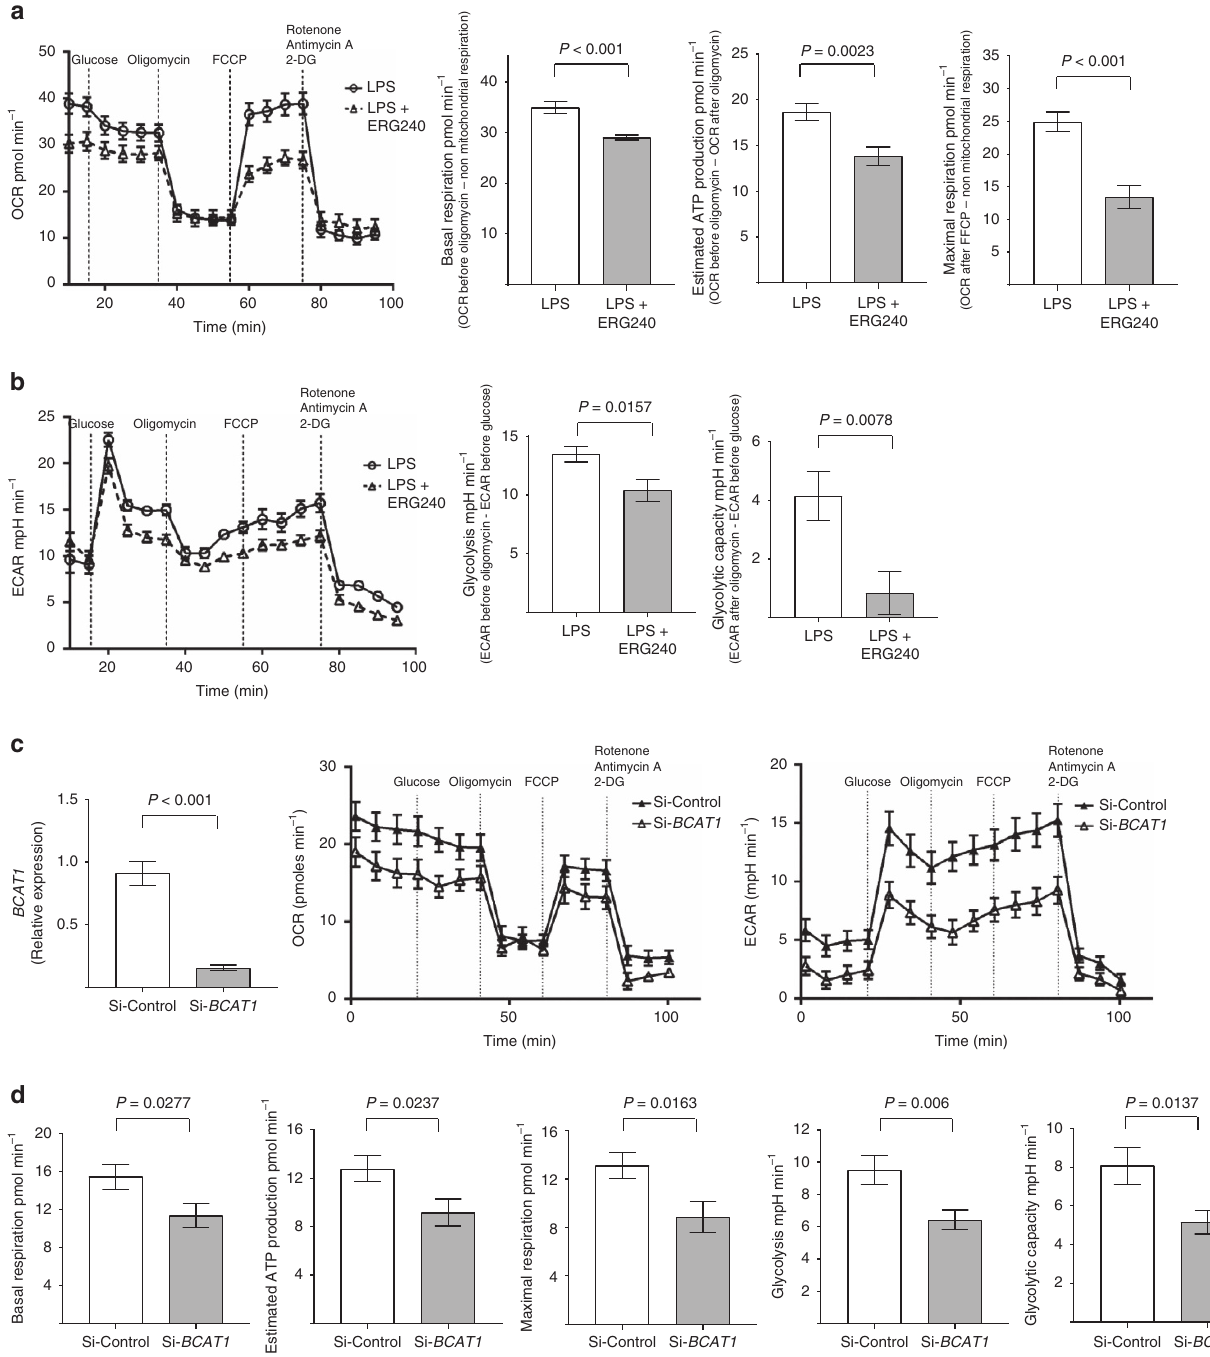
Figure 2 | BCAT1 inhibition reduces oxygen consumption and glycolysis in human macrophages. ( a ) Real-time extracellular OCR measurements in hMDMs (left panel) that were previously treated with either LPS (100ngml (cid:2) 1 ) or LPS þ ERG240 (20mM) for 3h. OCR values were recorded following sequential treatments with glucose (5mM), oligomycin A (0.5 m M), carbonyl cyanide 4-(trifluoromethoxy) phenyl- hydrazine (FCCP, 1 m M) and a combination of 2-deoxy-D-glucose (2-DG, 50mM), antimycin A (1 m M) and rotenone (1 m M). Basal respiration, estimated ATP production, and maximal respiration are shown in the right panel. n ¼ 3 healthy donor hMDMs were used in 12 technical replicates. The results are representative of